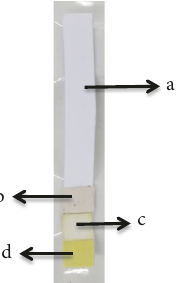
Figure 4: Design of paper-based analytical device: (a) support base, (b) Whatman filter paper contentFolin-Ciocalteu reagent, (c) Whatman